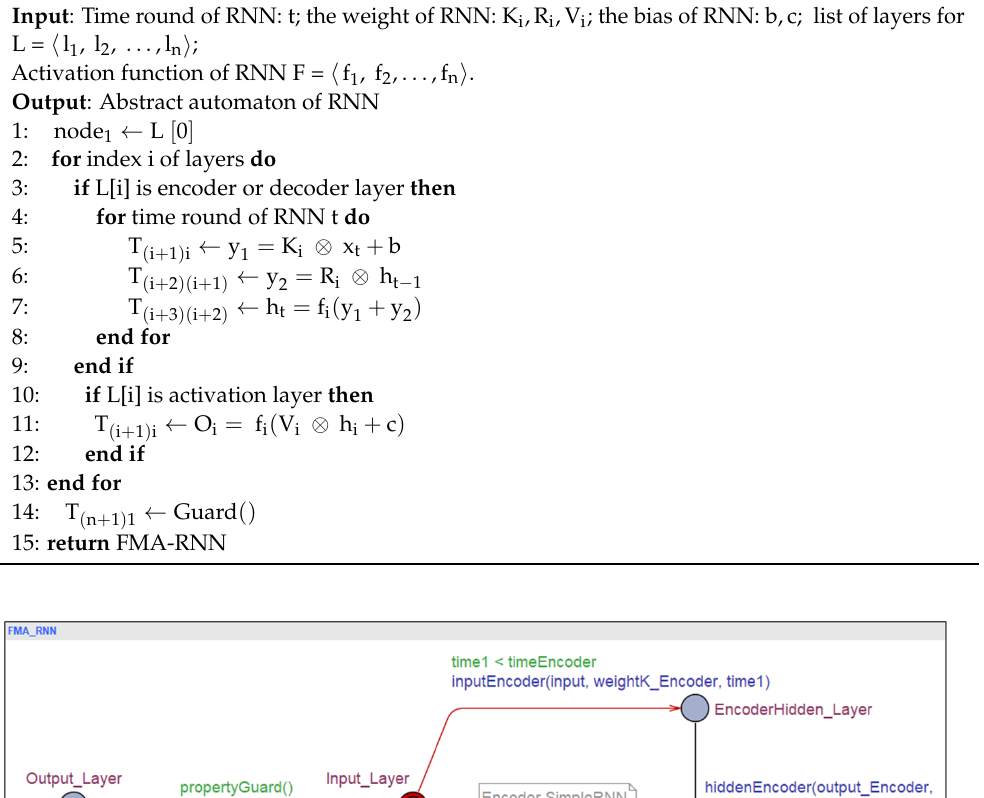
Algorithm 1 Convert the RNN Model to Timed Automata